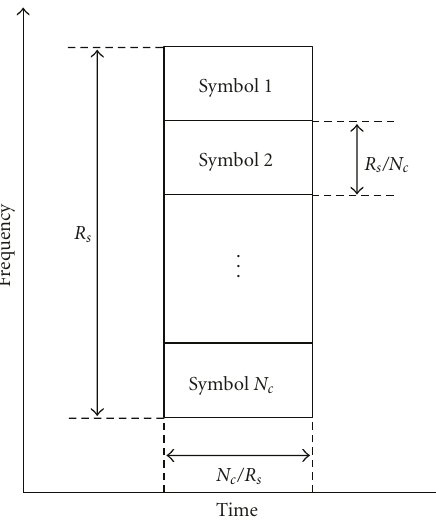
Figure 3: Representation of an OFDM block in time and frequency.